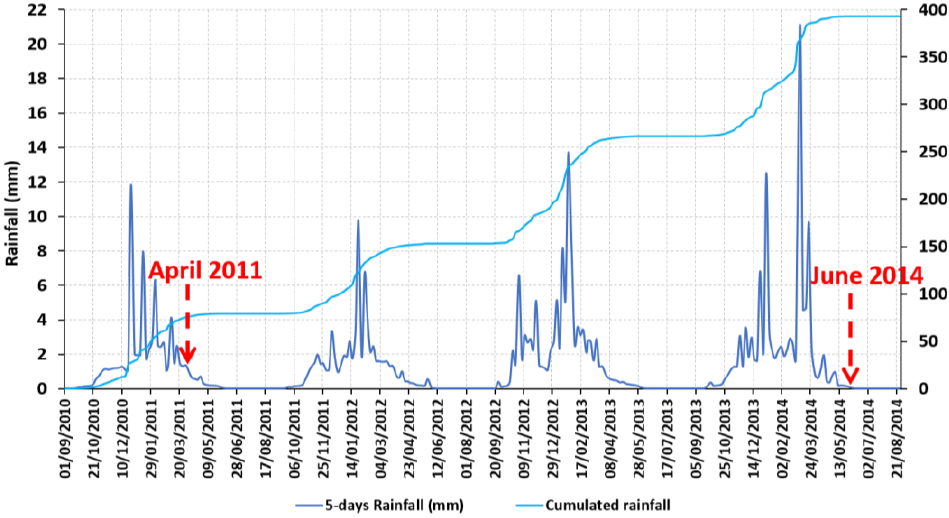
Figure 20. Rainfall data in Petra between September 2010 and 2014 Figure 20 . Rainfall data in Petra between September 2010 and 2014 [90].